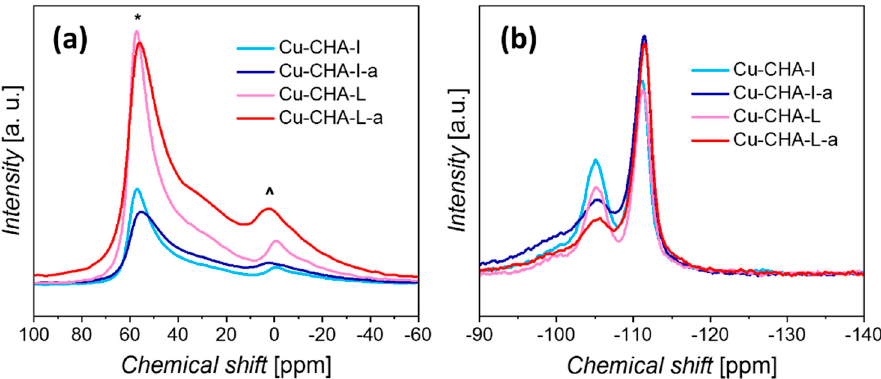
Figure 7. ( a ) 27 Al and ( b ) 29 Si solid state NMR spectra of Cu-CHA-I, Cu-CHA-I-a, Cu-CHA-L, Cu- CHA-L-a. In 27 Al NMR spectra, the peaks marked with “*” and “^” were attributed to tetrahedral Al incorporated into the framework and extra-framework octahedral Al,